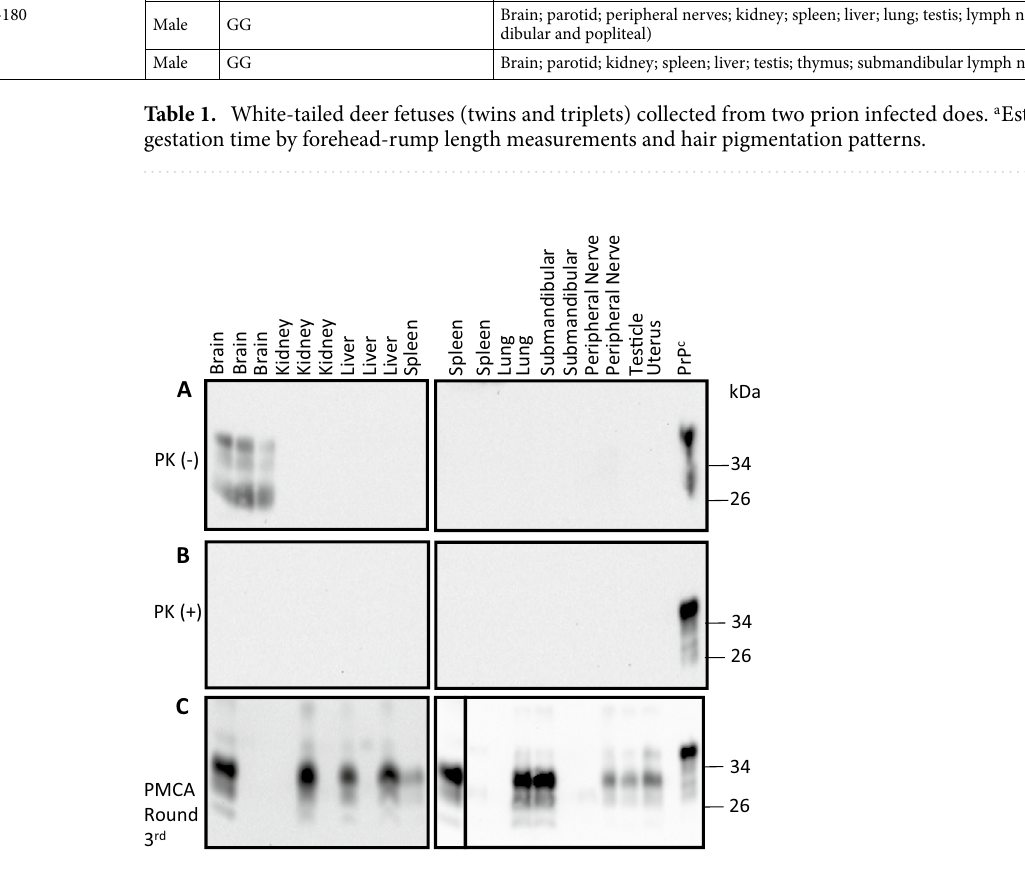
Figure 1. PrP C and PrP Sc screening in white-tailed deer fetal tissues using western blot and PMCA. Western blot analysis of representative fetal tissue samples prior ( A ) and after ( B ) PK treatment. ( C ) Results from the same representative samples depicted in ( A ) and ( B ) after PMCA analysis. Numbers at the right of each panel represent molecular weight markers (in KDa). “PrP C ” denotes brain extracts from Tg1536 mice not treated with PK and used as additional molecular weight markers. The solid line within panel 1C denote images taken from different